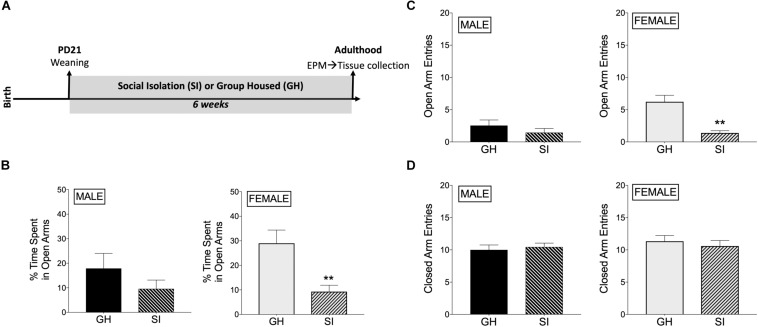
Effects of housing condition during adolescence on anxiety-like behavior in adulthood as measured in the elevated plus maze (EPM). (A) Experimental design of the study. (B) Male SI and GH rats did not differ in % time spent in open arms (TSOA) [TSOA/(TSOA + closed arm time)], whereas the % TSOA was significantly decreased in SI compared to GH female rats. (C) Male SI and GH rats did not differ in the number of open arm entries (OAE), whereas the number of OAE was significantly decreased in SI compared to GH female rats. (D) Neither male nor female SI and GH rats differed in the number of closed arm entries. n = 9–11/group; GH, group housed; SI, socially isolated; Asterisks indicate significant difference compared to GH control; ∗∗p < 0.01.